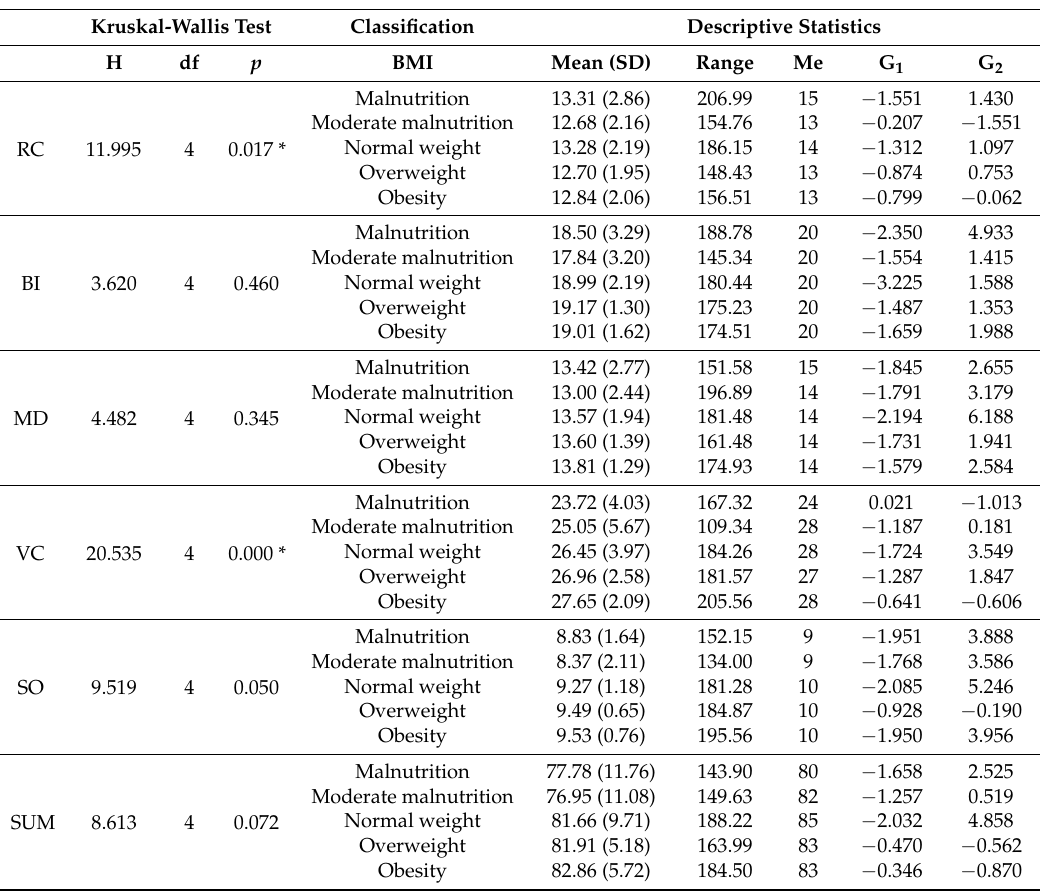
Figure 3. Average range of the scores for perceptual skills in the sample of girls. Table 6. Kruskal-Wallis test and descriptive statistics for perceptual skills according to BMI for the sample of